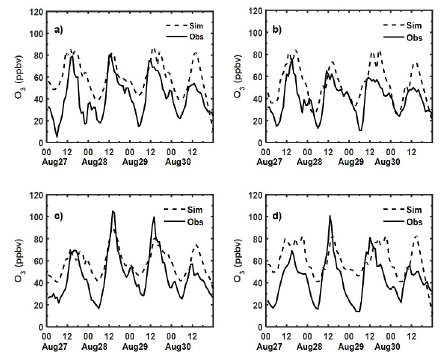
Fig.2 Simulated (dashed:) and observed (solid) surface O 3 at a) Queens College, b) CCNY (urban), c) Eatons Neck (coastal), and d)